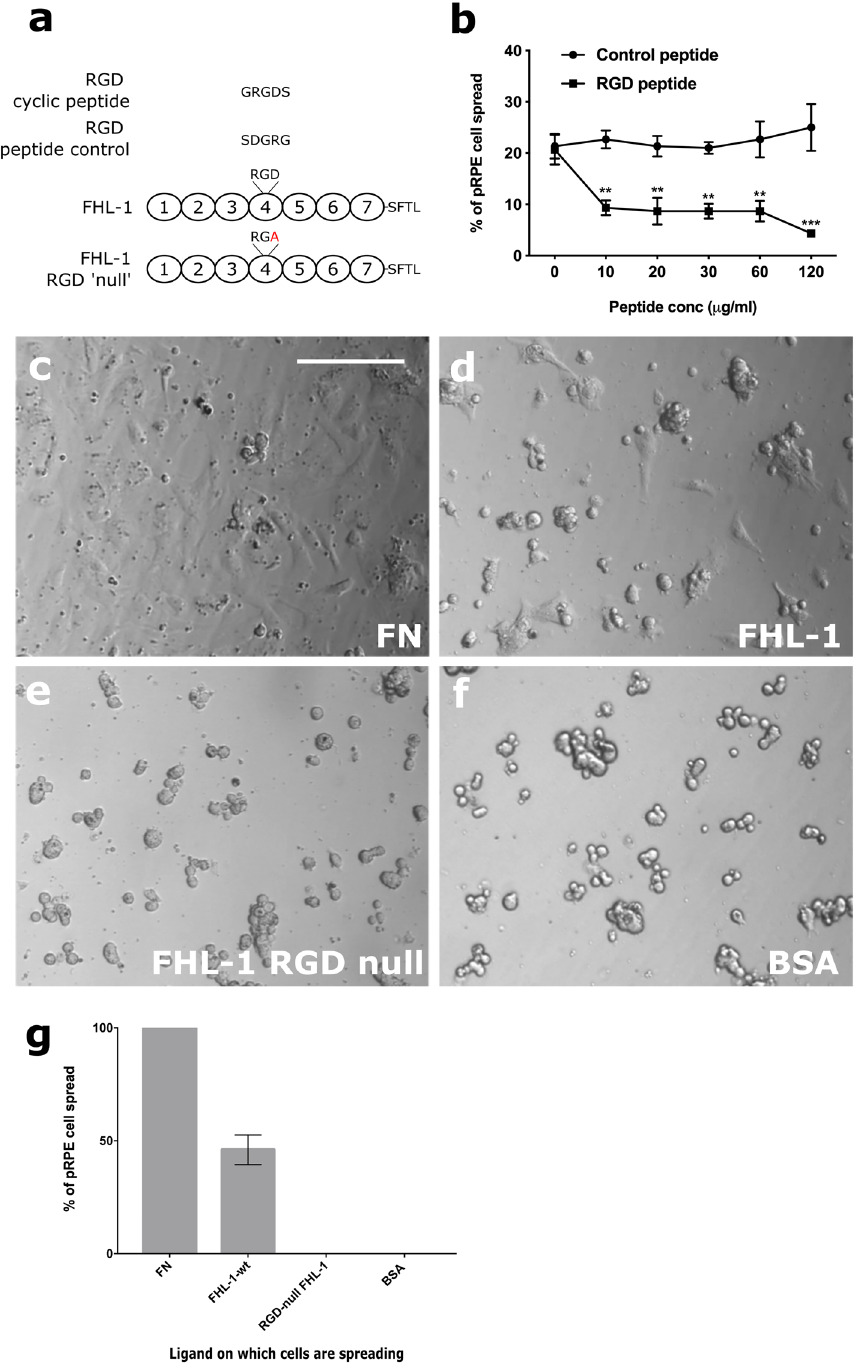
Figure 4. RPE cell α5β1 integrin recognises the RGD binding motif in FHL-1. ( a ) Schematic showing the design of both the RGD cyclic peptide and the scrambled peptide control, as well as the location of the aspartic acid mutation to an alanine residue for the creation of the RGD null FHL-1 protein. ( b ) The spreading of primary RPE cells to immobilised FHL-1 was inhibited with increasing concentrations of the cyclic RGD peptide: no inhibition was observed under the same conditions with the control scrambled peptide. Data comprises n = 3 ± s.e.m. Statistical analysis was performed using Student’s t test at each peptide conc., where ** P < 0.01, and *** P < 0.001. The binding of the α5β1 integrin to the RGD binding domain in FHL-1 is tested by incubation of primary RPE cells with ( c ) fibronectin, ( d ) FHL-1, ( e ) FHL-1 RGD null, or ( f ) BSA. ( g ) Percentage of spread cells were calculated and compared to the positive control, fibronectin. Data are the average results of the three independent experiments and each performed in triplicate. Images in ( c - f ) are representative of 3 independent experiments. Data in ( g ) represent n = 3 ± s.e.m. Scale bar represents 100